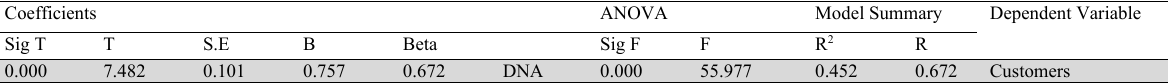
The results of the simple regression analysis for exploring the impact of the organizational DNA doesn’t on customers in commercial banks in Madaba